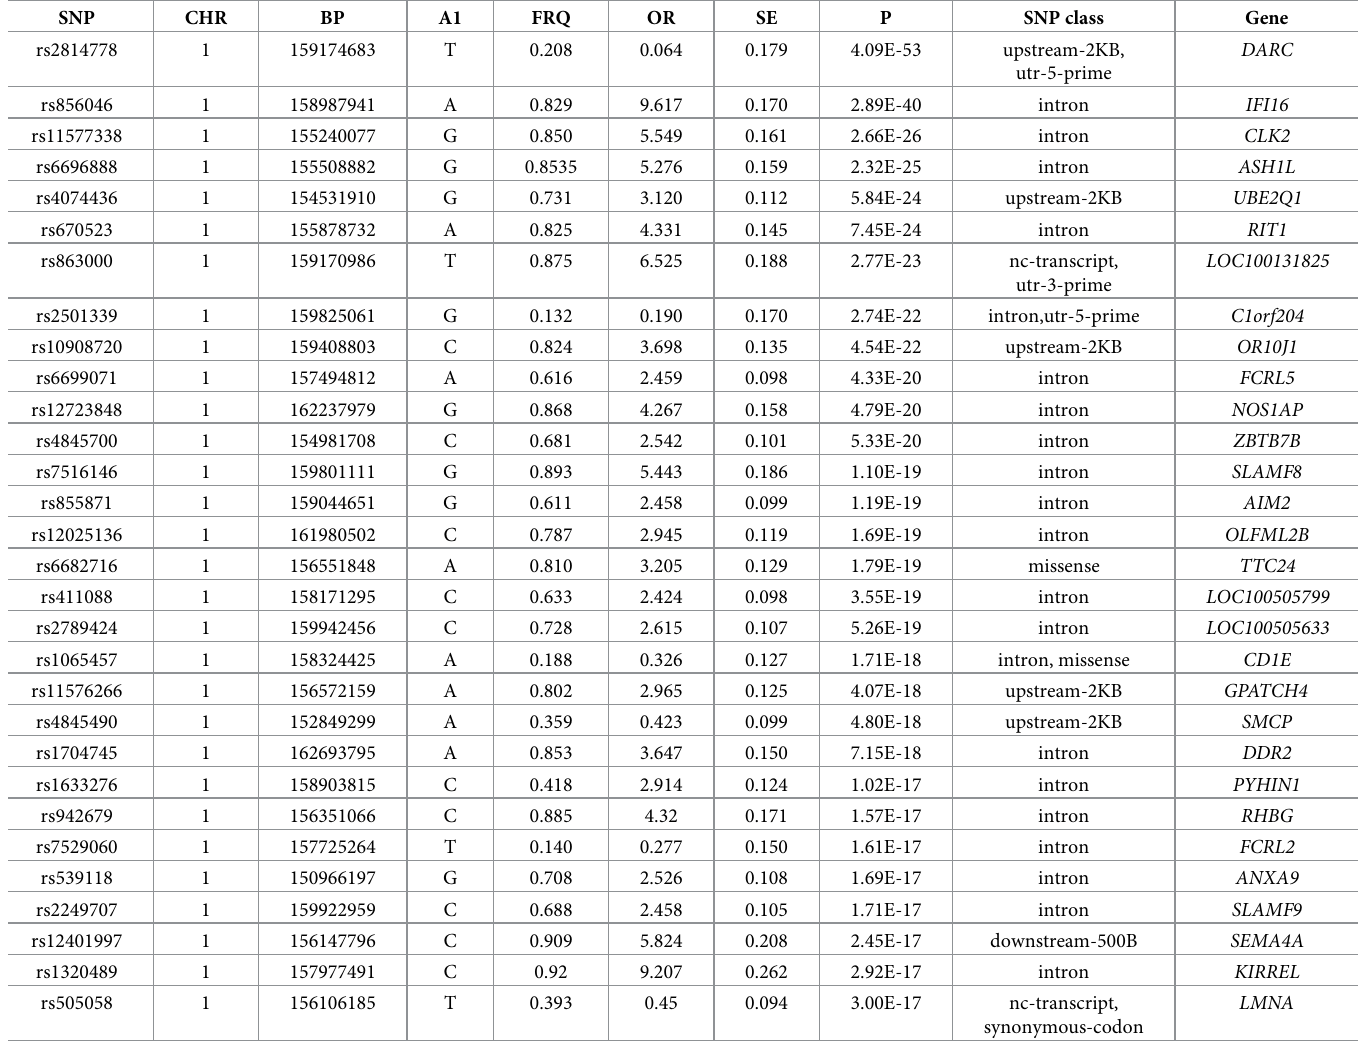
Table 1. Most significant loci in discovery